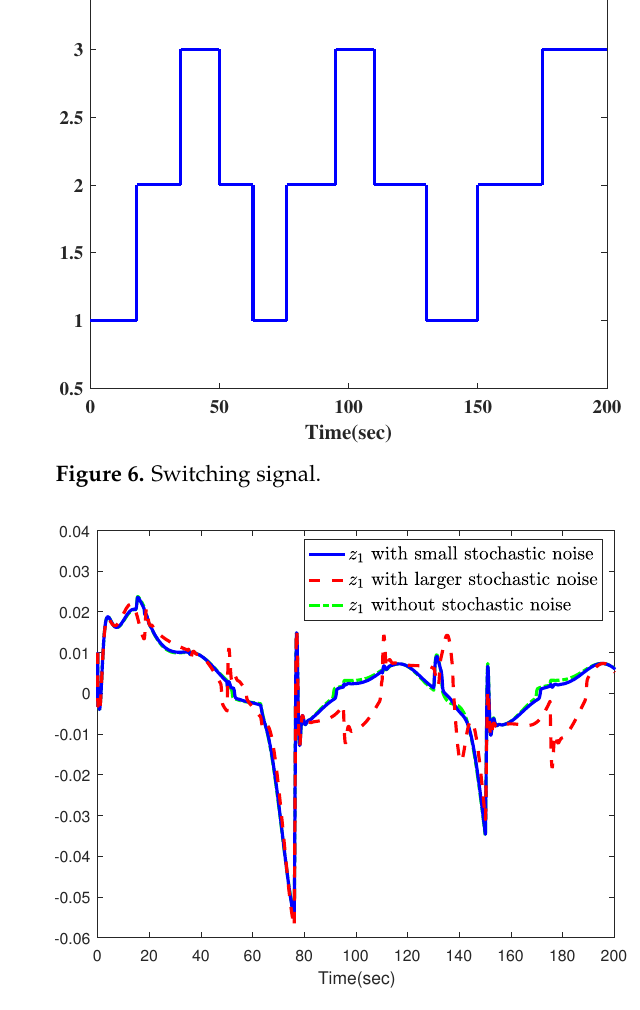
Figure 7. Influence of stochastic noise on the tracking effect under TD2.